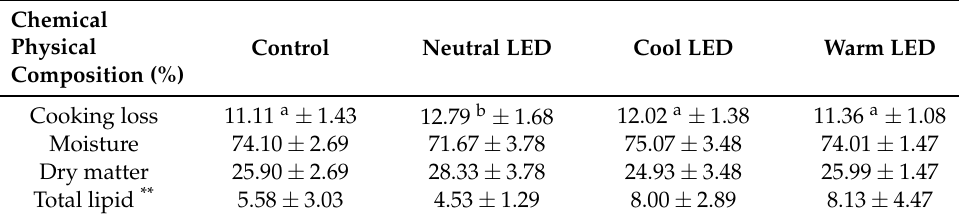
Table 1. Physical and chemical characterization of breast meat samples obtained from red chickens to different light treatments.